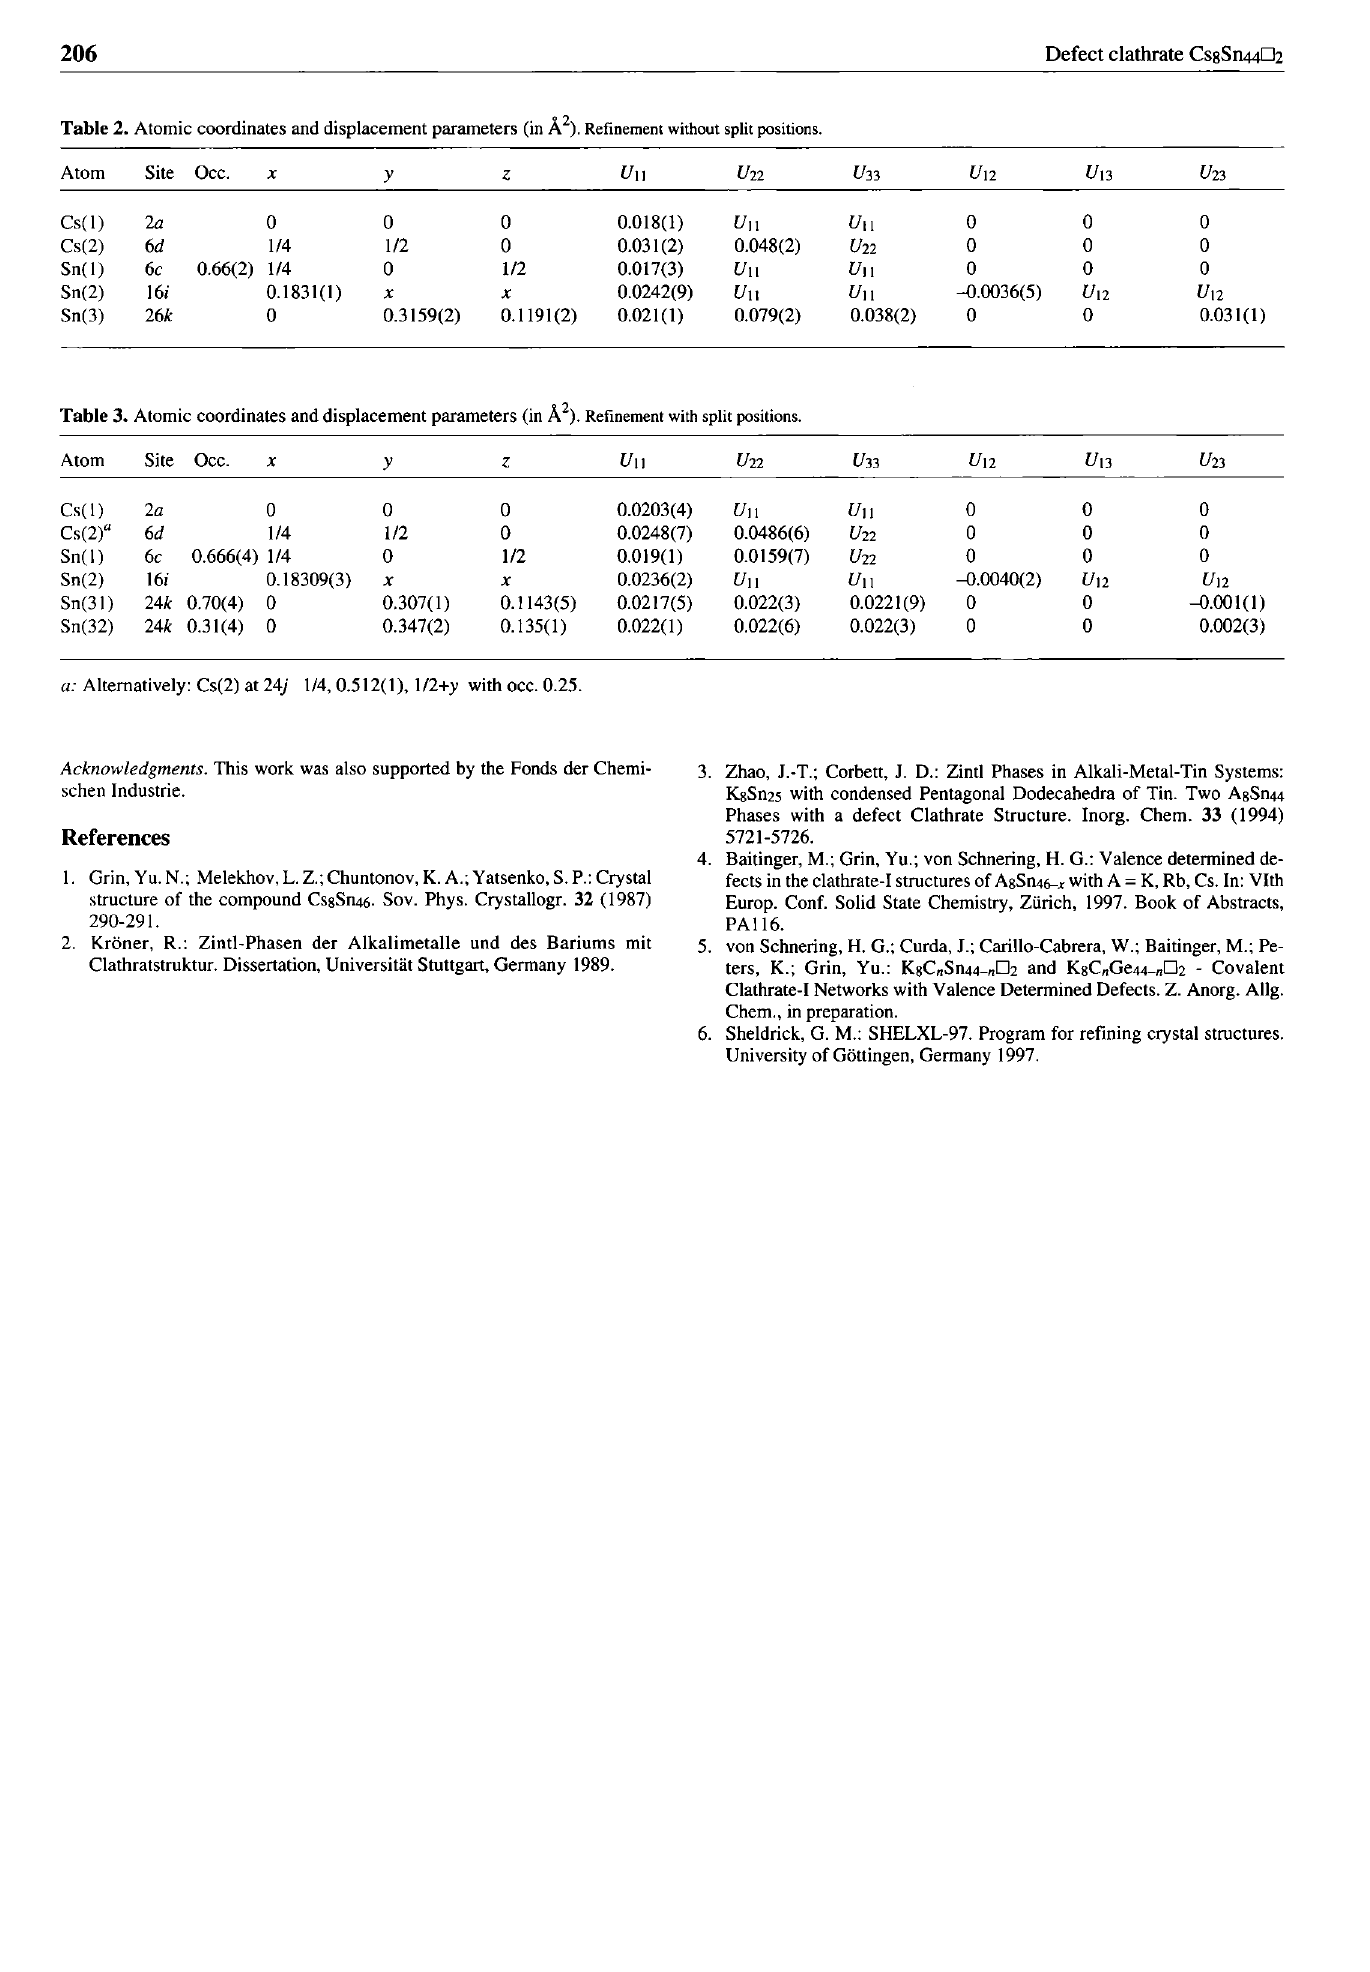
Table 2. Atomic coordinates and displacement parameters (in Ä 2 ). Refinement without split positions. Atom Site Occ.